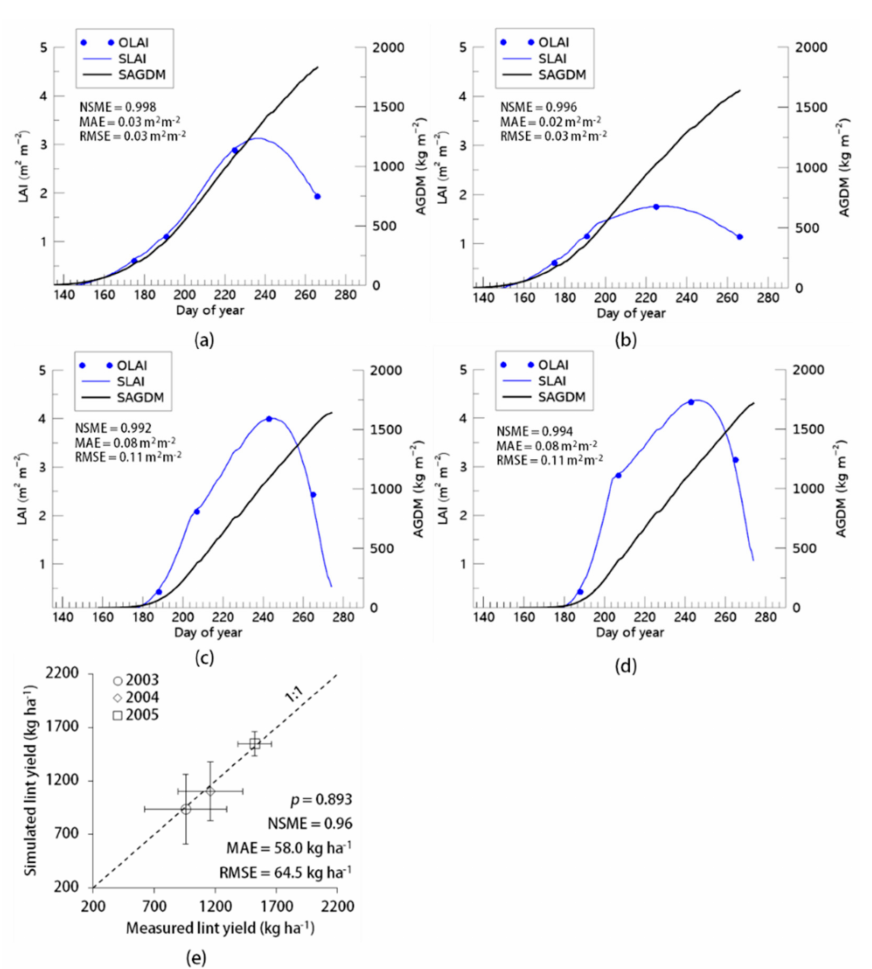
Figure A1. Simulated and measured cotton growth at irrigation intervals of ( a ) 7.5 h and ( b ) 8.5 h, and irrigation amounts of ( c ) 4 mm and ( d ) 6 mm at the Plant Stress and Water Conservation Laboratory field, Lubbock, Texas, USA. ( e ) Comparison between simulated and measured lint yields for the three years (2003–2005). LAI and AGDM represent leaf area index and above-ground dry mass, respectively.